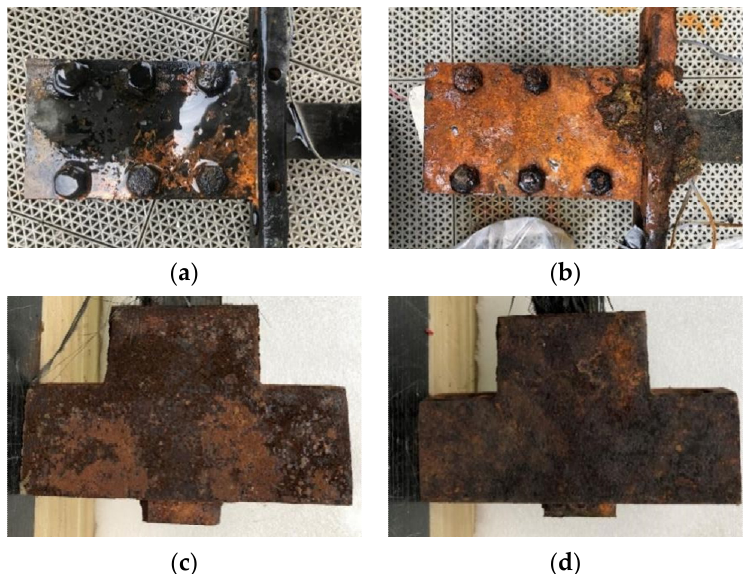
Figure 4. Clamp anchors and wedge anchors after accelerated corrosion. ( a ) C-72. ( b ) C-144. ( c ) W-72. ( d ) W-144.